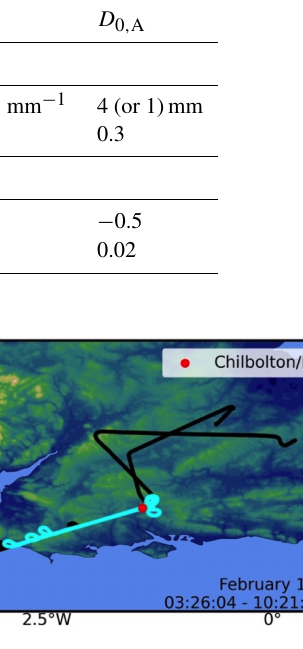
Table 4. The prior and uncertainty used in ENCORE-ice. The means at the lowest radar gate are given in the physical state space, and the rest are in the transformed state space (i.e. log 10 ). Retrieval is performed using two different sets of the prior; the second set uses values in the parentheses, and the rest remain unchanged. All radar gates above the lowest gates are perturbed by an AR1 red noise process with a vertical correlation of 0.999 and a standard deviation that is half of the standard deviation at the lowest gates. Pristine ice